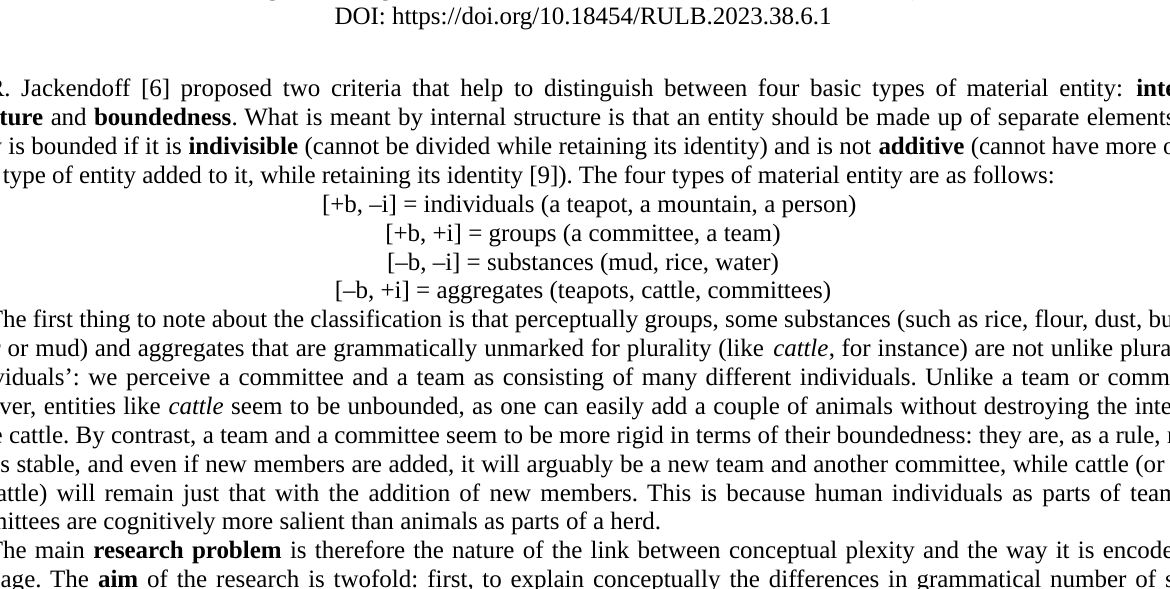
Figure 1 - Degree of individuation of entities (after V. Evans, 2010) DOI: